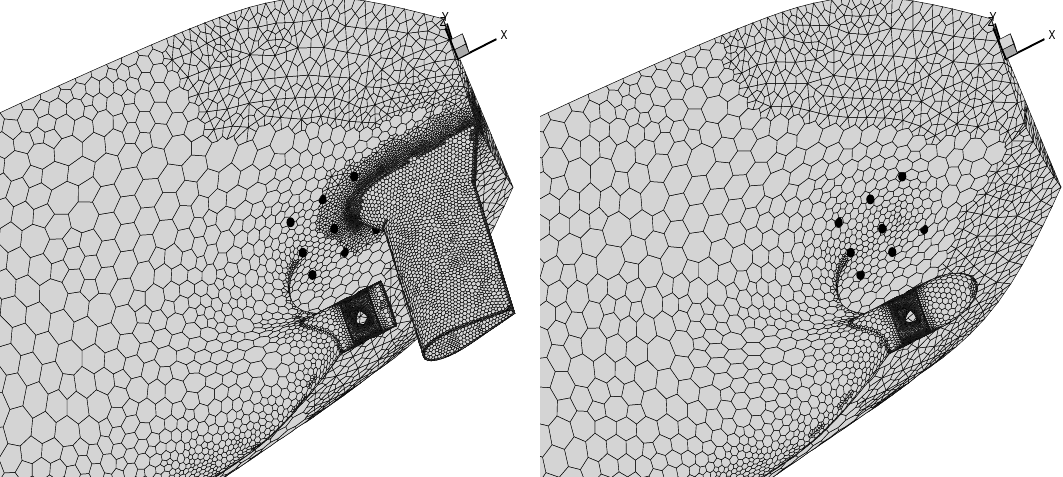
Figure 31. Grids on the hull geometry with ( left ) and without ( right ) rudder. Transducer locations are denoted in black scatters. Propeller mesh is omitted in the figure.